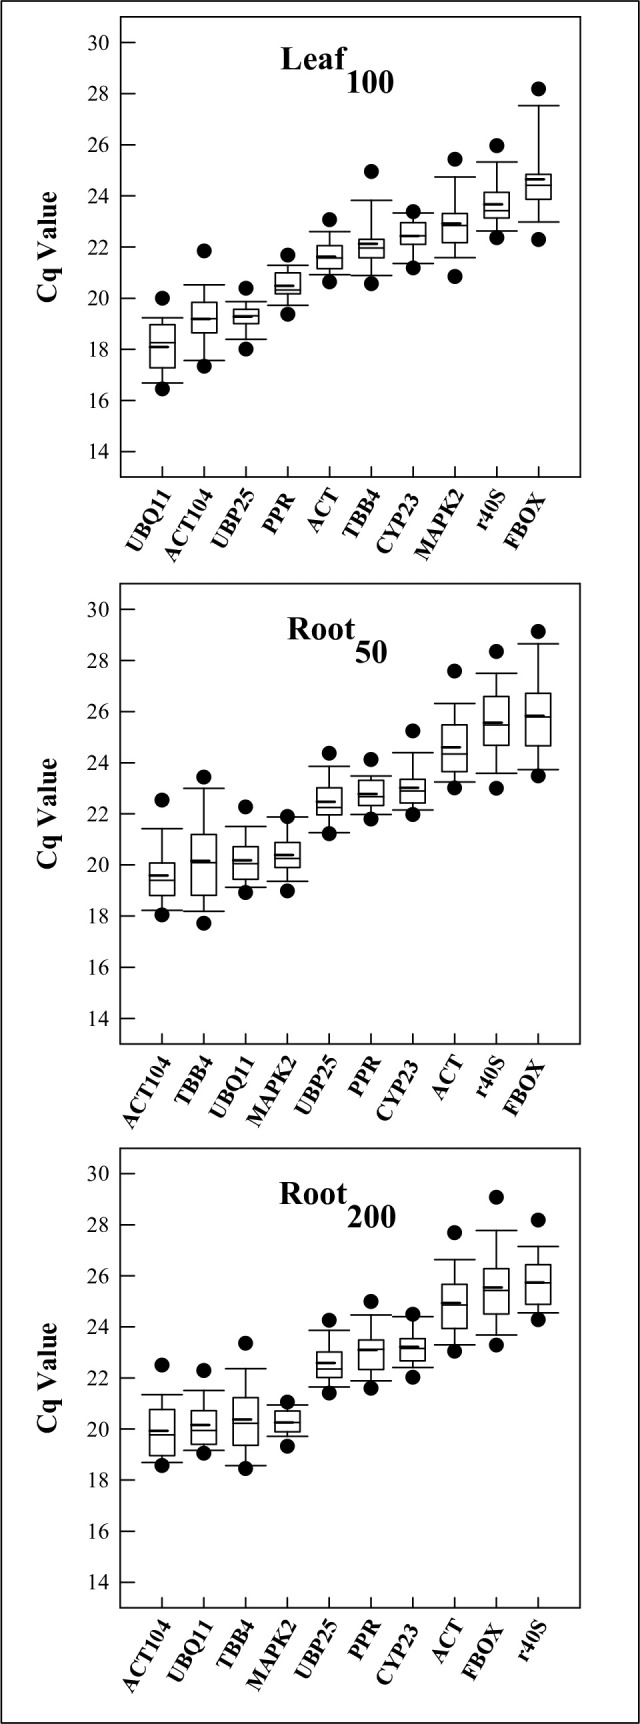
Quantification cycle (Cq-value) of 10 candidate reference genes in leaf and root samples of Calotropis procera under different salt stress (A) Leaf100 (100 mM NaCl), (B) Root50 (50 mM NaCl) and (C) Root200 (200 mM NaCl). The Boxplot indicates the interquartile range. The horizontal dashed line represents the mean and the solid line the median. The upper and lower dashes represent the maximum and minimum values. Dots indicate the lowest and highest Cq value.